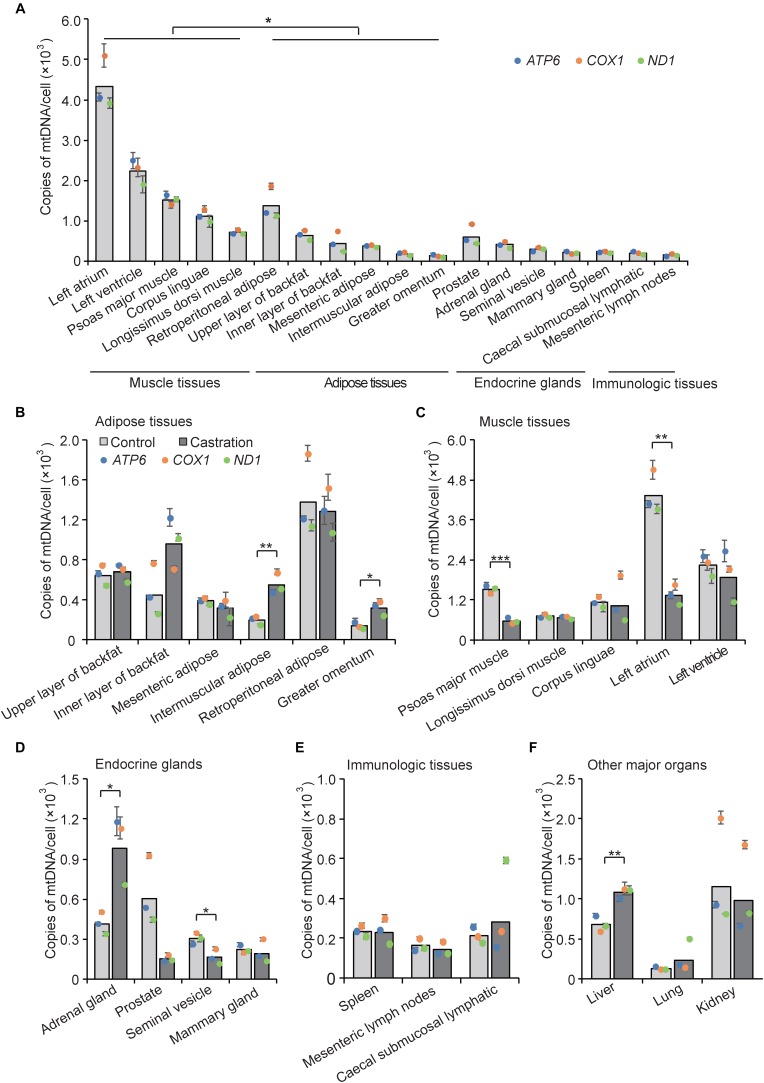
mtDNA copy number was determined by qRT-PCR analysis of three mitochondria-specific genes (ATP6, COX1, and ND1). Twice the ratio of ATP6/COX1/ND1 to single-copy nuclear gene number reflected the relative mtDNA content, and the solid bars represent mean values of mtDNA contents individually calculated by ATP6, COX1, and ND1. (A) Tissue profiling of mtDNA copy numbers in five categories of tissues in wild-type pigs. mtDNA copy numbers per cell in adipose tissues (B), muscle tissues (C), endocrine glands (D), immunologic tissues (E), and other major organs (F) in control and castrated pigs. All data are expressed as means ± SD, n = 4 in each group. Comparison between control and castration groups was performed by Student’s t-test, ∗P < 0.05, ∗∗P < 0.01, ∗∗∗P < 0.001.